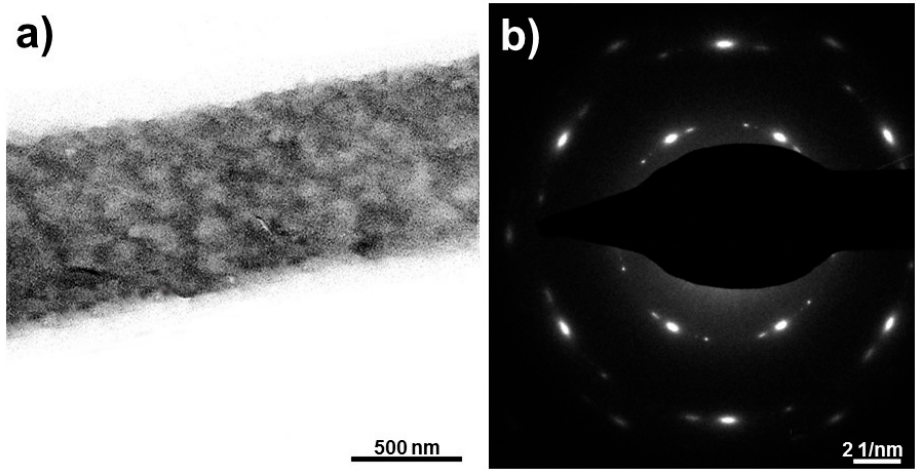
Figure 3. ( a ) HR-TEM image and ( b ) corresponding SAED pattern of PAN/GO/H 2 O composite fiber.